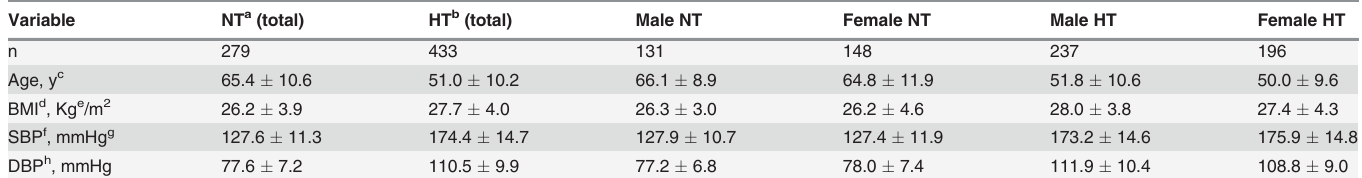
Table 1. Characteristics of the study population.